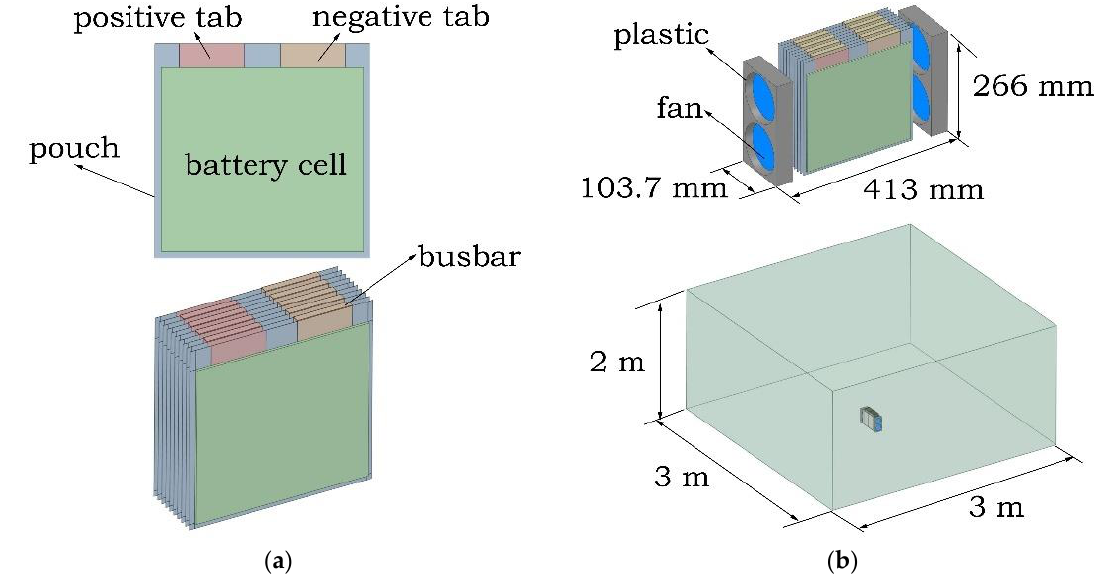
Figure 1. Schematic showing the battery components and fluid domain: ( a ) single-battery cell and battery module, and ( b ) the supply fan system and domain dimensions.